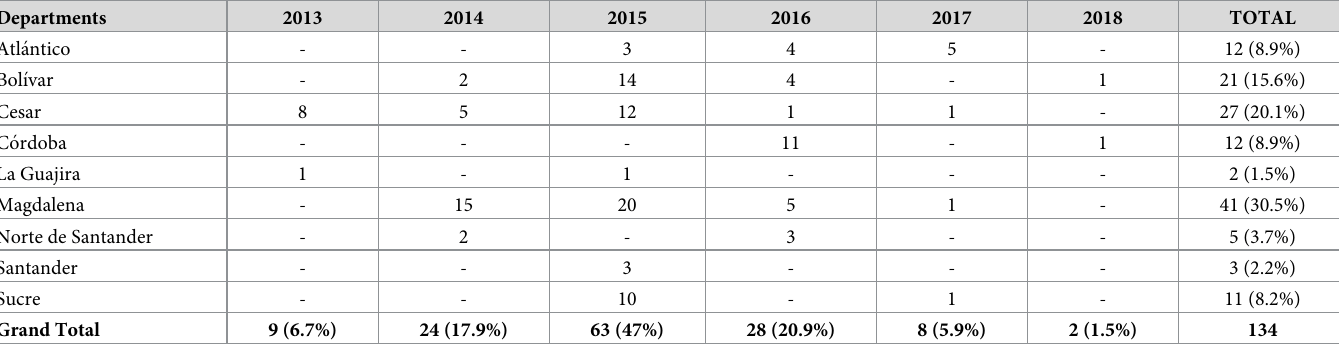
Table 2. Distribution of CSF outbreaks in